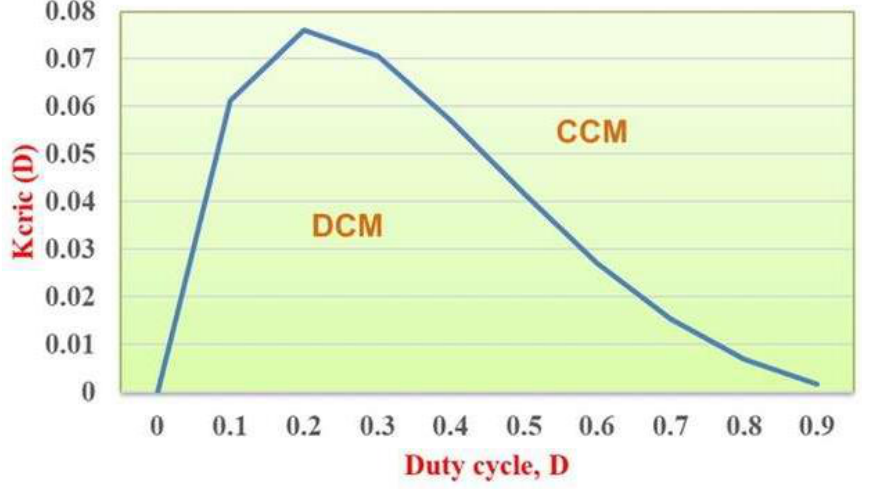
Figure 8. Proposed converter Boundary condition.